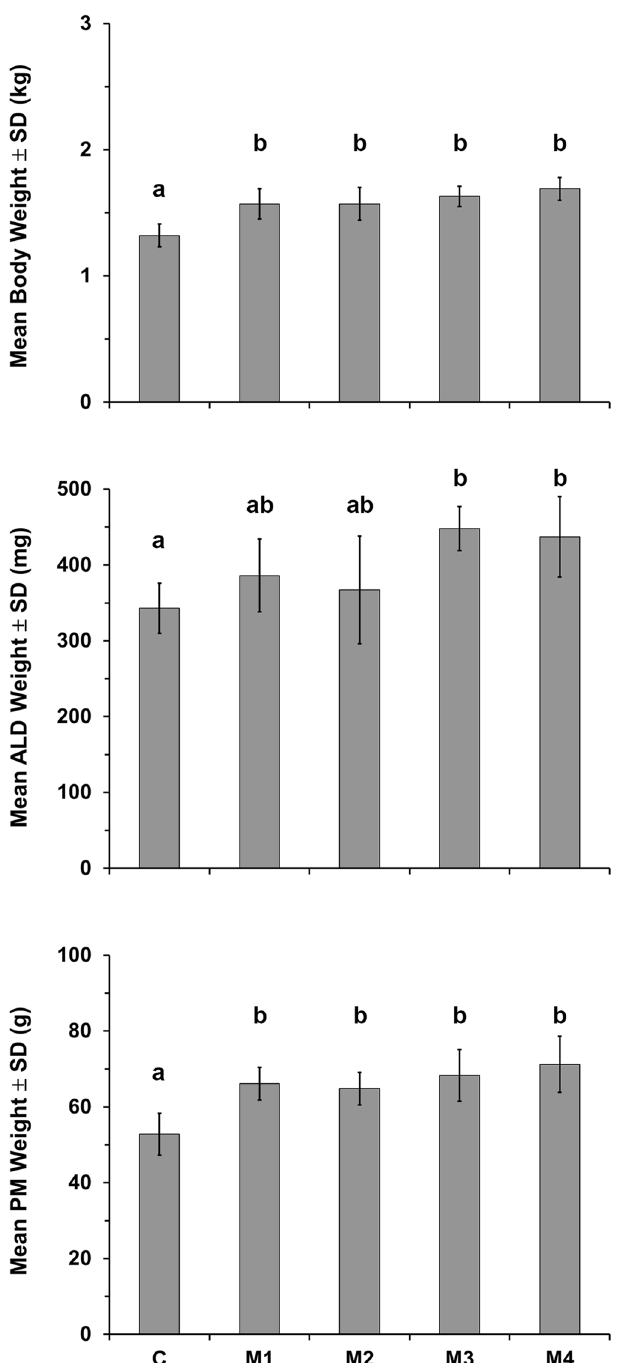
Figure 1. Body and muscle weights in control and mesterolone-treated groups. C: control group; M1, M2, M3, M4: groups treated with 4, 8, 12, and 16 mg/kg mesterolone, respectively. ALD: anterior latissimus dorsi muscle; PM: pectoralis major muscle; SD: standard deviation. Different alphabets ( a , b ) indicate significant difference among the groups (ANOVA, LSD post-hoc